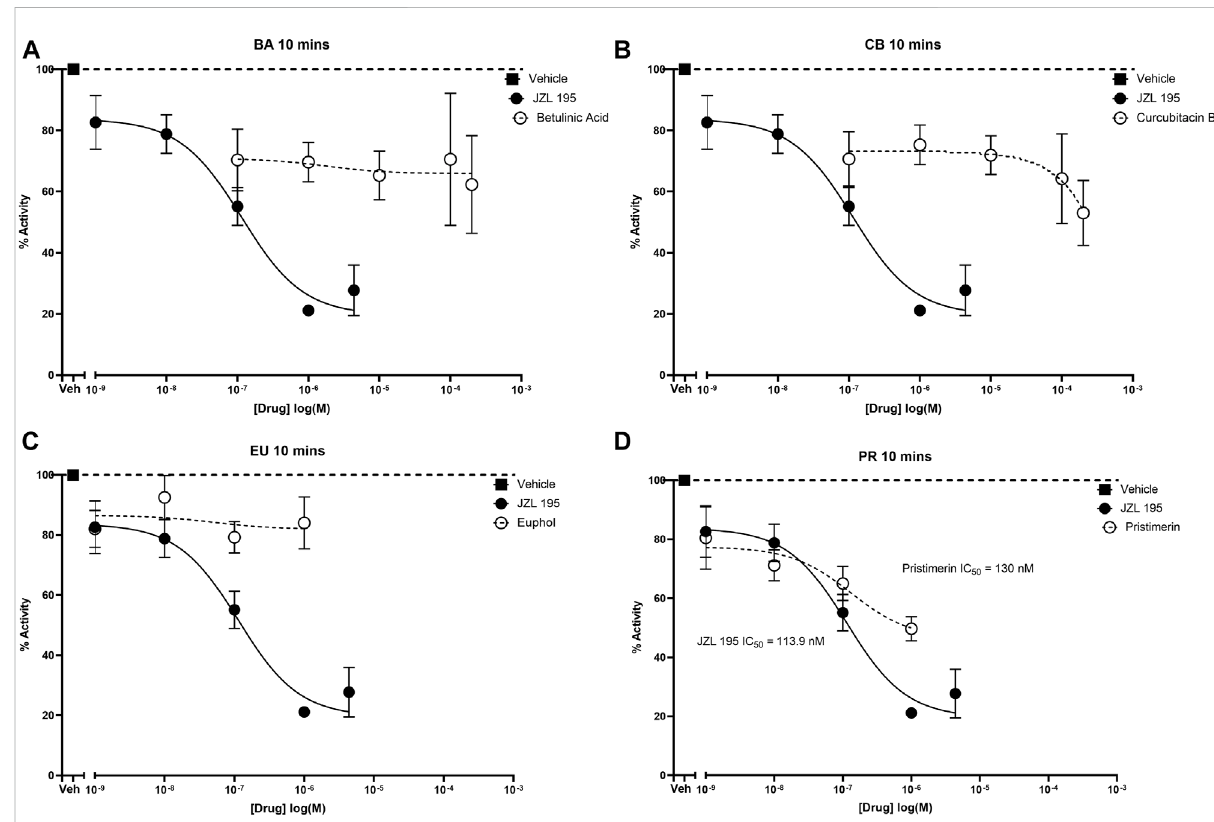
FIGURE 3 Inhibitoryeffectsofvariousconcentrationsofbetulinicacid,cucurbitacinB,euphol,pristimerinandJZL195onhumanrecombinantMAGLafter 10 min of incubation. Each point represents the mean ± SEM of values obtained from 3 to 5 experiments.